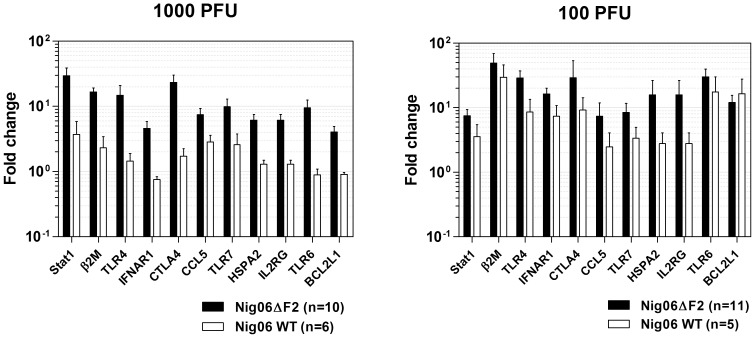
Impact of PB1-F2 on expression profiles of several genes representative of the host response.Total RNA isolated from lungs of chickens infected with 1000PFU (A) and (B) (day 2 pi) were reverse-transcribed and used to quantify expression of several host response markers by qPCR: signal transducer and activator of transcription 1 (STAT1, Gene ID: 424044), beta-2-microglobulin (β2M, Gene ID: 414830), toll-like receptor 4 (TLR4, Gene ID: 417241), interferon (alpha, beta and omega) receptor 1 (IFNAR1, Gene ID: 395665), cytotoxic T-lymphocyte-associated protein 4 (CTLA-4, Gene ID: 424106), chemokine (C-C motif) ligand 5 (CCL5, Gene ID: 417465), toll-like receptor 7 (TLR7, Gene ID: 418638), heat shock 70 kDa protein 2 (HSPA2, Gene ID: 423504), interleukin 2 receptor gamma (IL2RG, Gene ID: 395199), toll-like receptor 6 (TLR6, Gene ID: 771173), and B-cell CLL/lymphoma 2-like 1 (BCL2L1, Gene ID: 373954). Gene expressions were normalized with the β-actin gene (Gene ID: 396526) expression level and presented as fold increase relative to mock-treated chickens. Data are means ± SEM obtained from the indicated number of chickens.